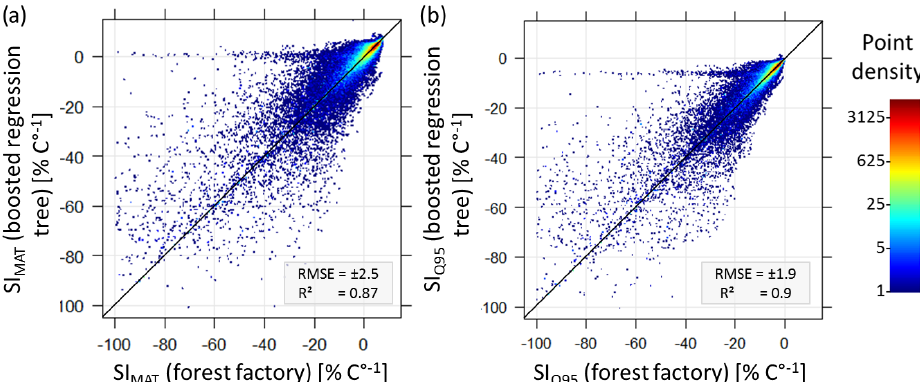
Figure B2. Comparisons of temperature sensitivity (SI MAT and SI Q 95 ) based on the forest factory and boosted regression tree model. Colours indicate point density. Diagonal is the 1 : 1 line.